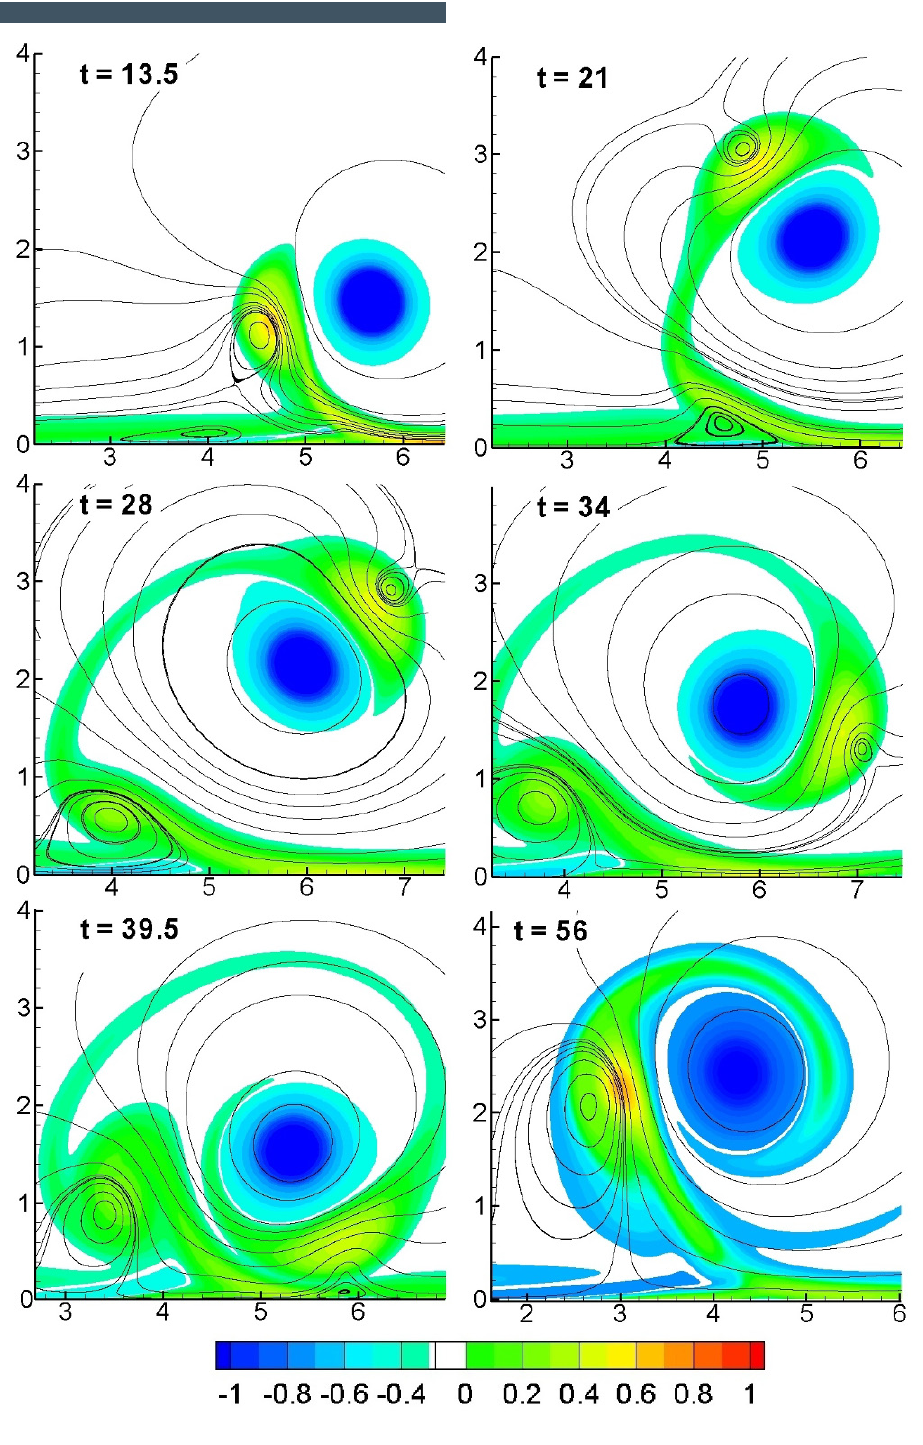
Figure 7. The considered flow for Re = 10000 . The eruptions of the boundary layer and the creation of another near-wall recirculation zone can be observed for ( t = 28 , t = 56)